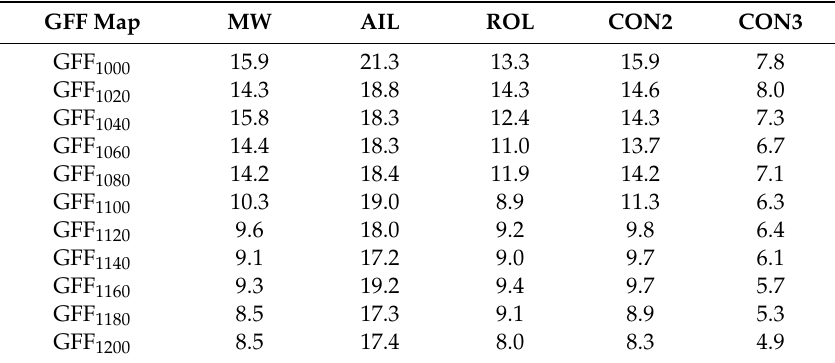
Figure 9. The edge e ff ected region (EER) identified by the removal of outer lines (ROL) method using the grid-level fire frequency map that employed 1200 fire-year maps (GFF 1200 ). The jagged solid lines show the mean FF L for each line ordered from (a) west to east, and ( b ) north to south. The horizontal dashed lines indicate the EER ROL thresholds. Table 2. Percent of the 2900 × 2900 grid-level fire frequency (GFF) maps identified as edge e ff ected regions (EER) with reduced fire frequency (RFF). The 11 grid-level fire frequency (GFF N ) maps di ff er in the number of fire-year maps. The five methods compared are moving windows (MWs), agglomeration of inner lines (AILs), removal of outer lines (ROLs), and the consensus EER for at least two (CON2) or all three (CON3) of the MW, AIL and ROL